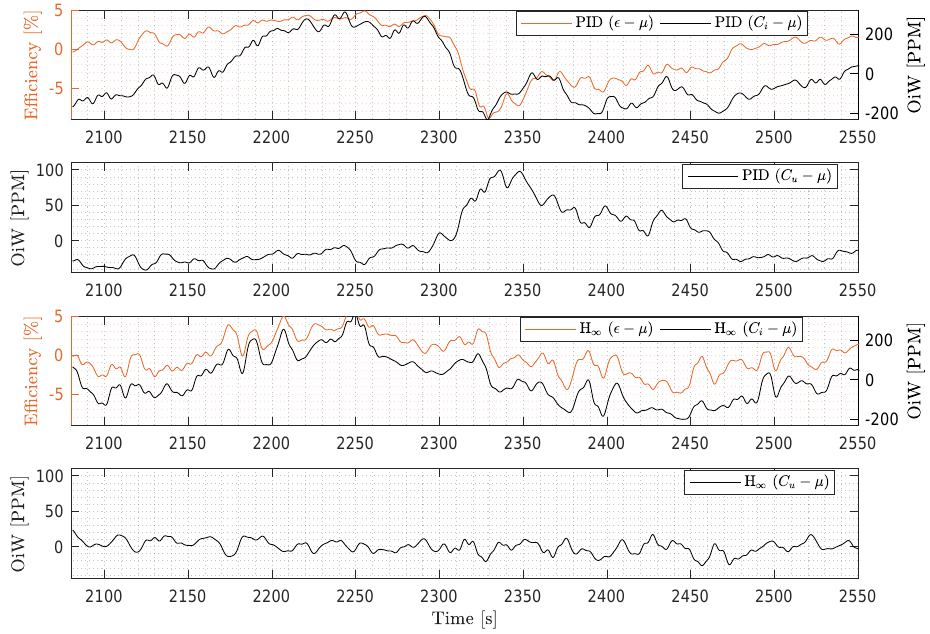
Figure 5. Experiment Results: controller evaluation with fluctuating flow rate, zoomed in on a portion of the experiment to show the dynamics of the OiW measurements. The mean has been subtracted to emphasize the dynamic relationship.